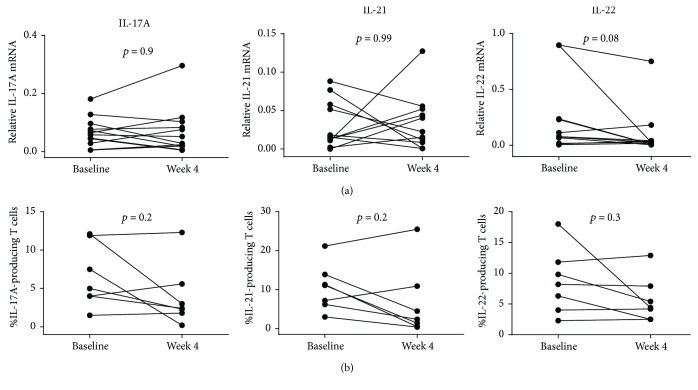
Comparison of mucosal gene expression and LP T cells expressing IL-17A, IL-21, and IL-22 between baseline and week 4 of adalimumab treatment. Gene expression was determined by rtPCR (a) and frequencies of IL-17A-, IL-21-, and IL-22-producing cells among LP CD3+ T cells were determined by flow cytometry (b). Gene expression data is displayed as the normalized ratios between the relative expression of the gene of interest and the housekeeping gene HPRT-1. Wilcoxon signed-rank test for comparison was applied on paired samples (rtPCR: IL-17A n = 12; IL-21 n = 11; IL-22 n = 11; flow cytometry: n = 7 for each cytokine).